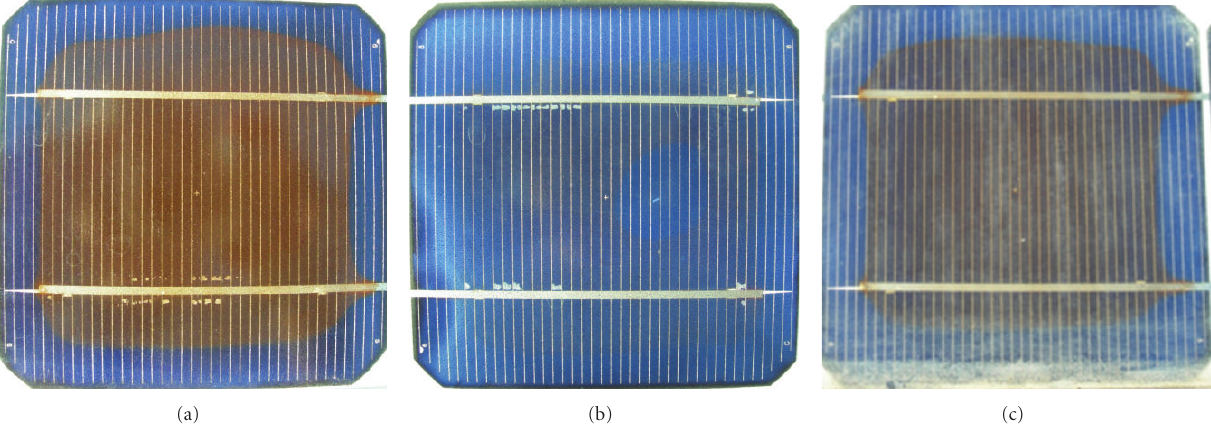
Figure 2: Various degradation e ff ects observed in 18-year-old SIEMENS M55 PV